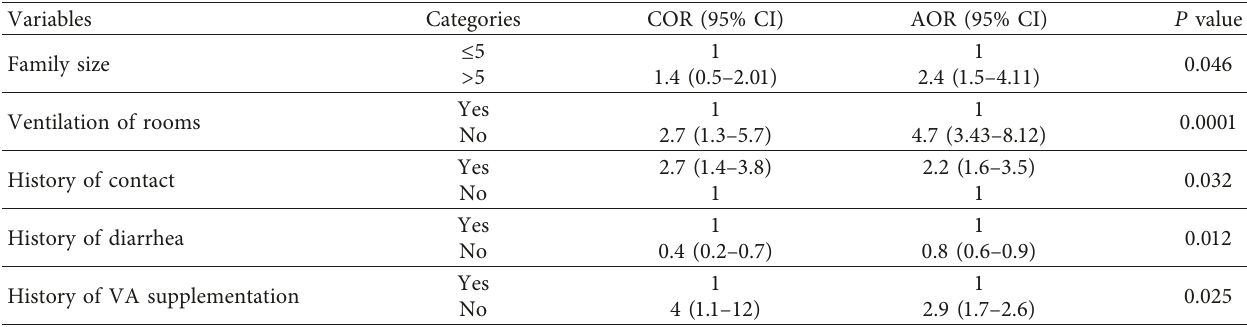
COR, crude odds ratio; CI, confidence interval; VA, vitamin A. Table 4: Independent factors for contracting rubella in Amuma Wuchale Kebele, Kuyu District, North Shewa Zone, Oromia Region, 2018.